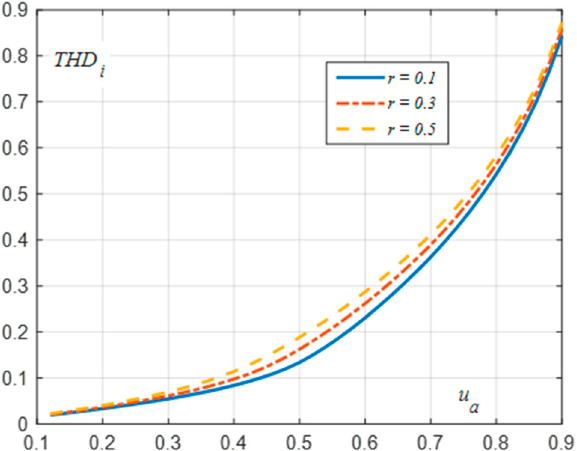
Figure 6. Harmonic content coefficient of circuit current as a function of load voltage amplitude and resistance.